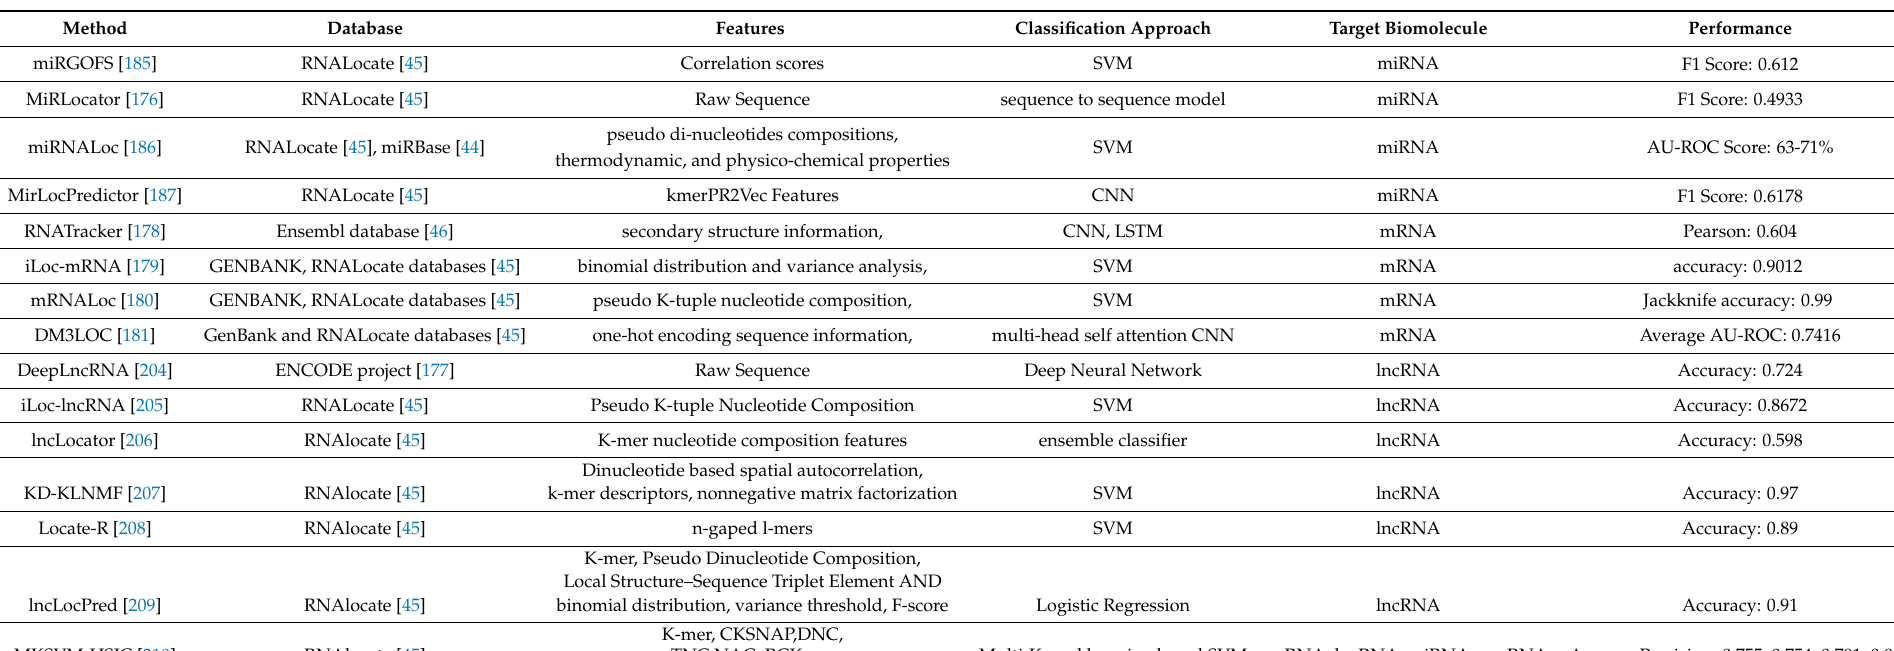
Table 7. Summary of machine and deep learning based methodologies for the sub-cellular location prediction of coding and non-coding